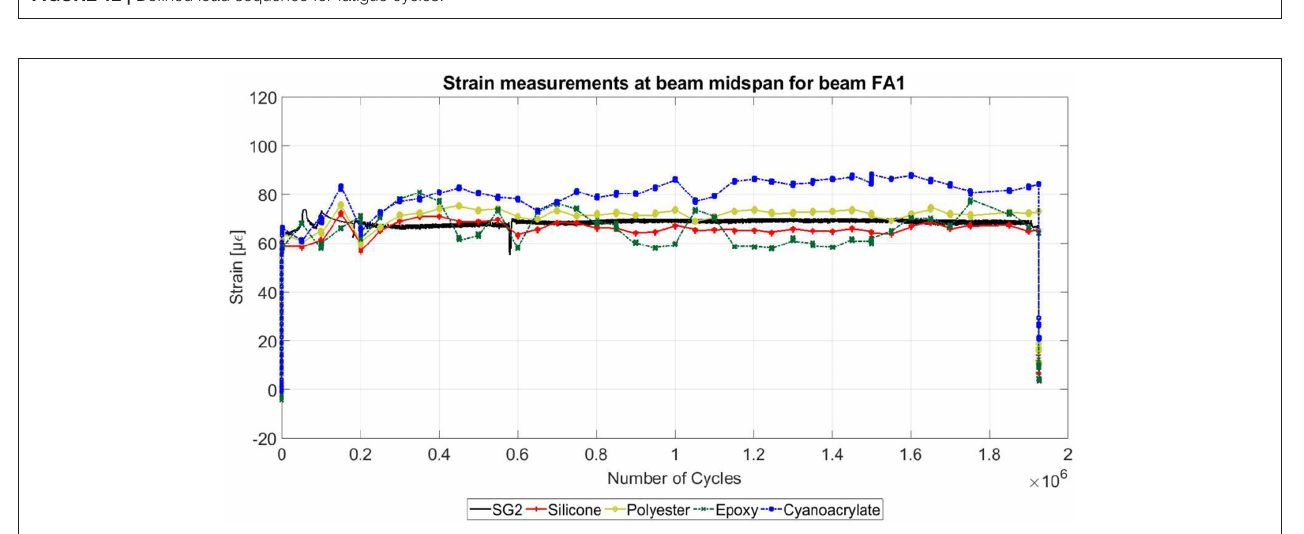
FIGURE 13 | Measured strain at beam FA1 mid-span over the load